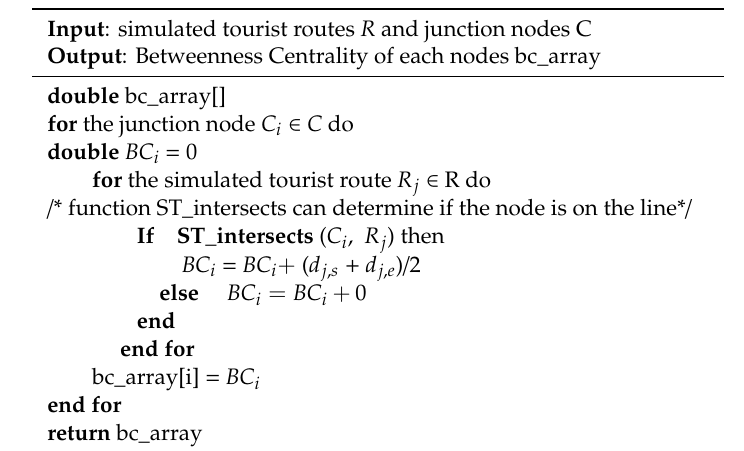
Table 1. Betweenness centrality calculation process of each junction